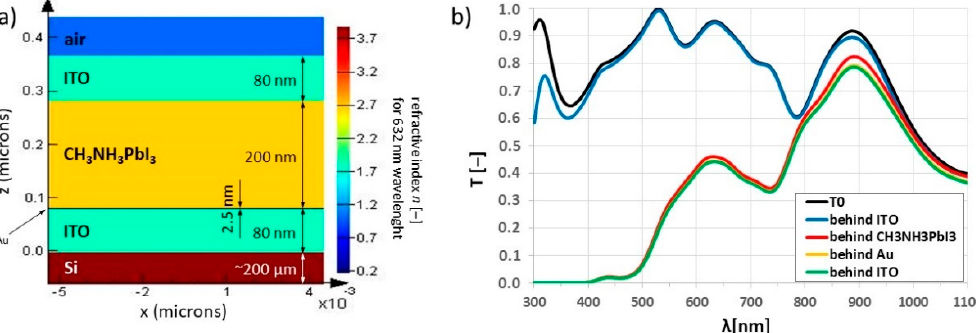
Figure 1. Simulation of the tandem structure based on c-Si and MALI ( a ) in the case of absorption in the wavelength range of PV cells operation ( b ) [35].